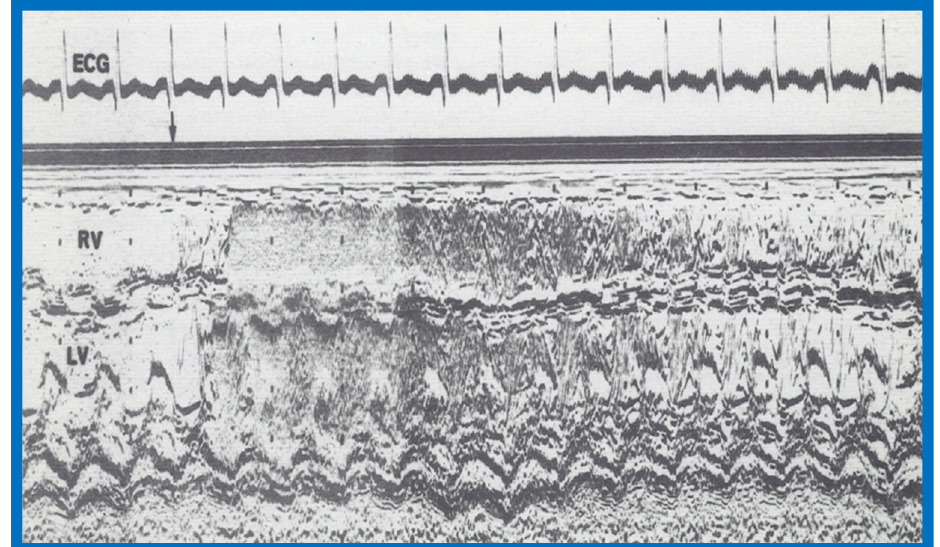
Figure 28. Selected M-mode recording from the parasternal short axis view of the left ventricle (LV) and right ventricle (RV) demonstrate the almost simultaneous appearance of contrast echoes in the LV and the RV, indicating that that the right-to-left shunt is at the ventricular level. The time of injection is marked by an arrow at the left top of the figure. ECG, electrocardiogram. Reproduced from Rao P.S., et al.